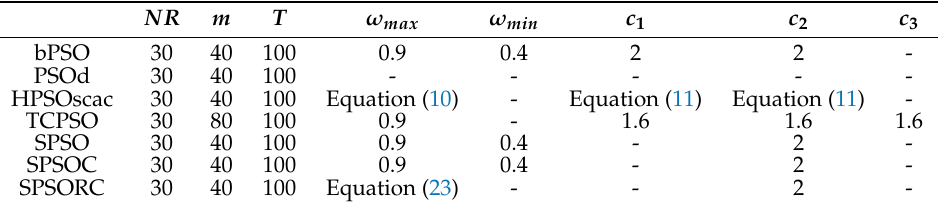
Table 2. Parameters for candidates.